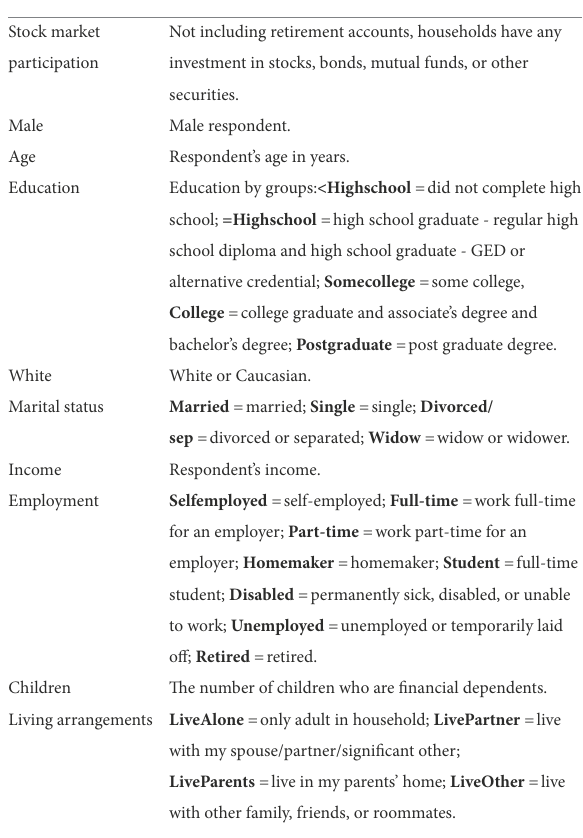
TABLE 8 The definition of demographic